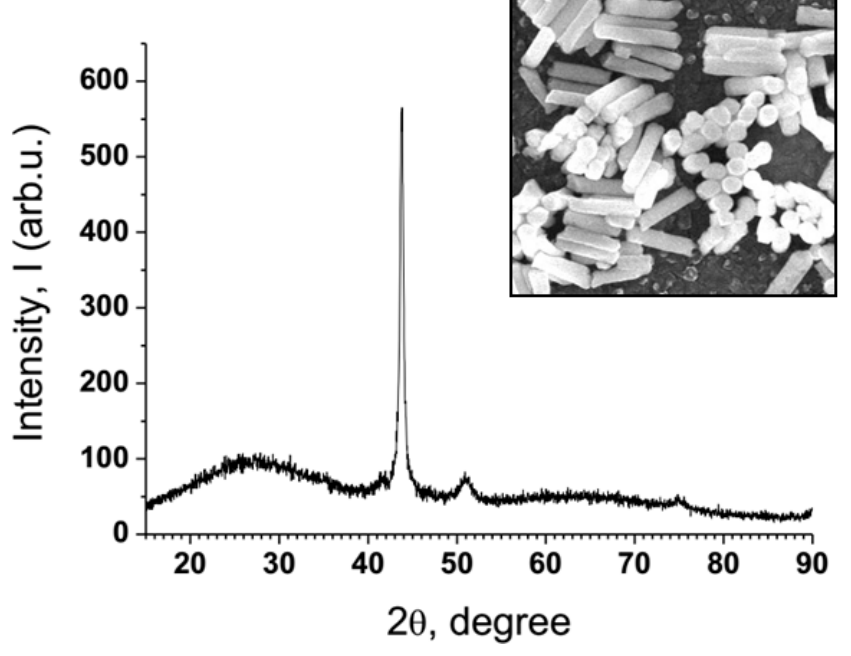
Figure 3. X-ray diffraction (XRD) pattern of the NiNPs nanocomposite material in PAAT. Figure 3. X-ray di ff raction (XRD) pattern of the NiNPs nanocomposite material in